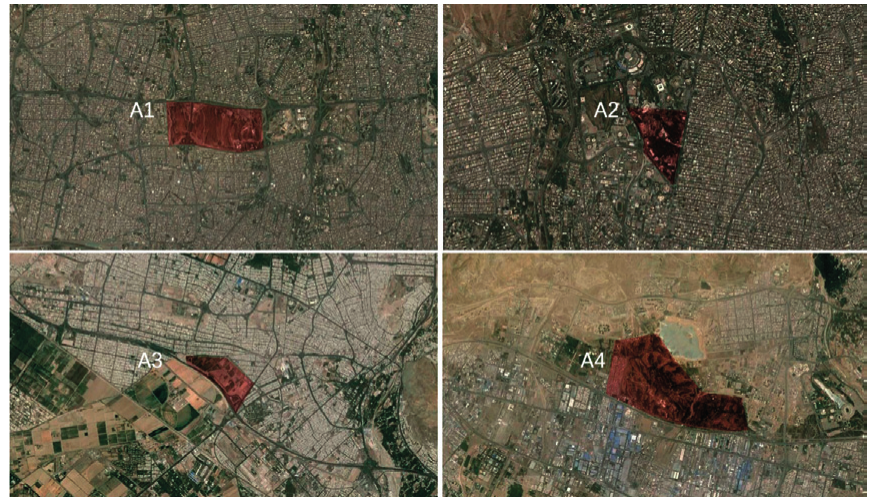
Fig. 3. The location of cases in